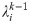
The Y-shaped edge junction issue.Left: the description of the population fluxes between λik-1 and λik is not trivial due to the Y-shaped edge junction. Right: each interior edge (= corridor) has been duplicated (at the same position), leading to a “V-shaped” junction between λik-1 and λik. Solid lines correspond to interior edges. The exchange rate between the populations from both sides of the edge, λik=λi′k′, are described by the parameter α.